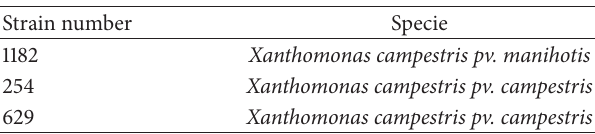
Table 1: Strains of Xanthomonas campestris used in the production of xanthan